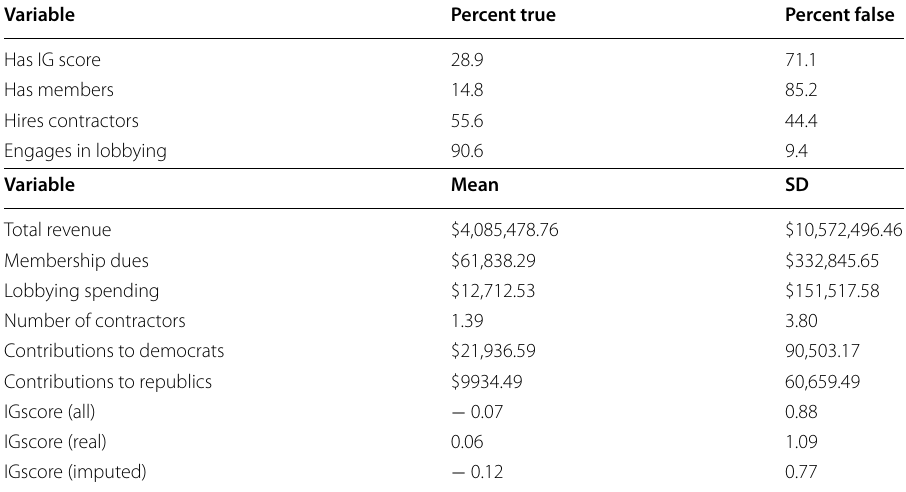
Table 1 Summary